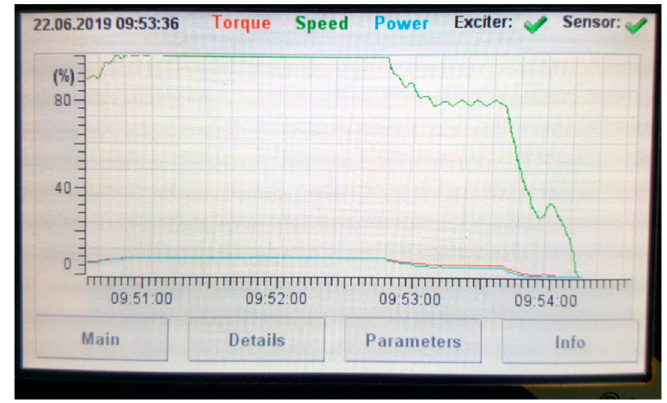
Figure 6. Exemplary reading of the graphical user interface (GUI).